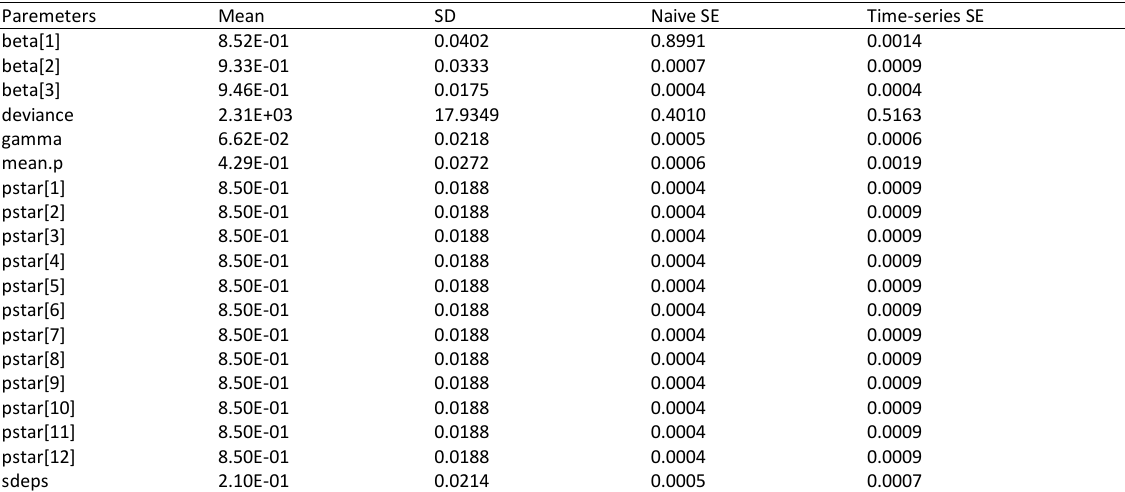
Table S5: Parameters of the model in which temporary emigration is random, survival is age-dependent and there is heterogeneity in the detection process, estimated using a Bayesian robust-design capture-recapture (CR) approach.